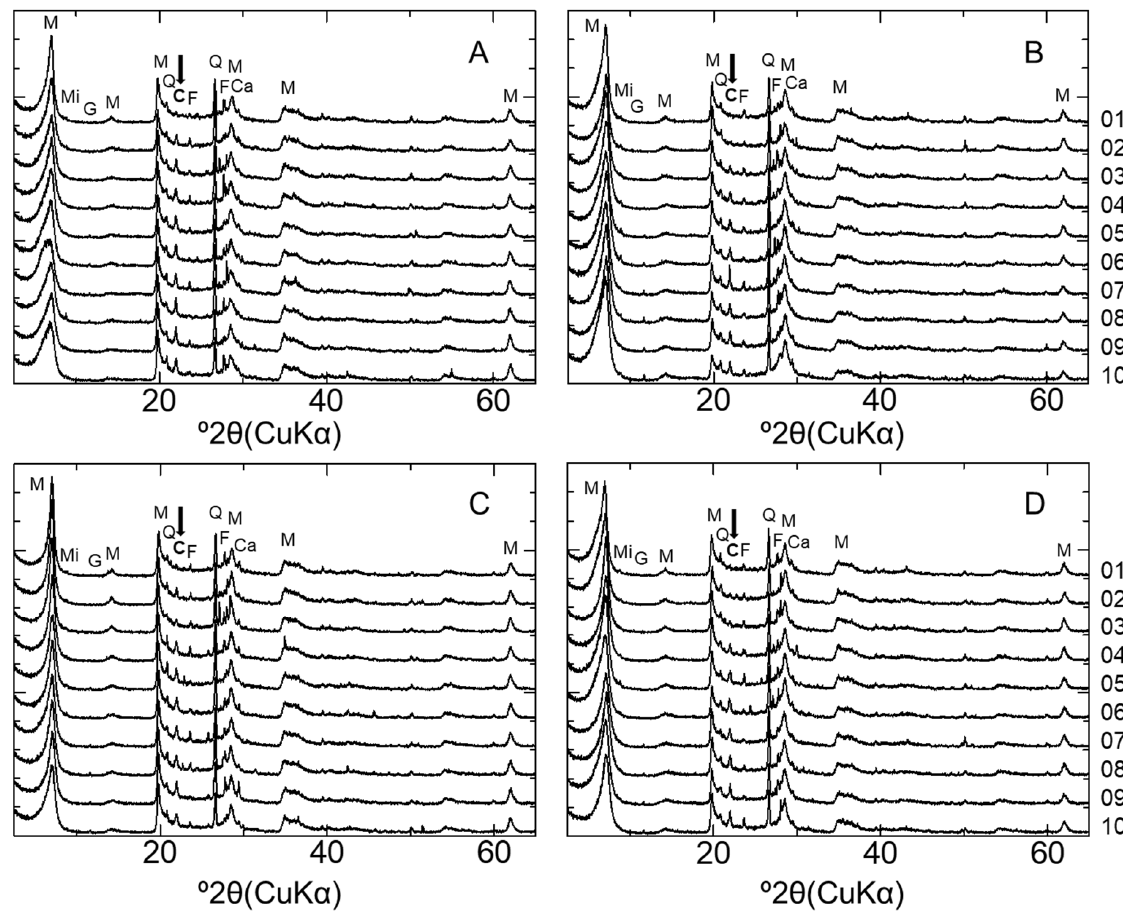
Figure 3. XRD patterns of bentonite in LAC-MX and OPC-MX. ( A ) LAC-MX_4.9 y, ( B ) LAC-MX_10 y, ( C ) OPC-MX_4.9 y, and ( D ) OPC-MX_10 y. M: montmorillonite; Q: quartz; C: cristobalite; F: feldspar; Mi: mica mineral; G: gypsum; Ca: calcite. Arrow pointing to cristobalite peak.